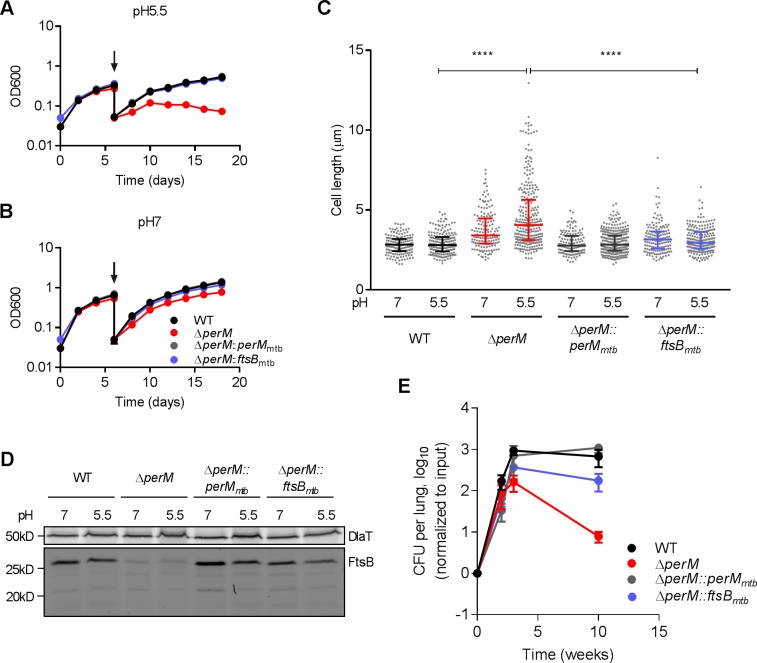
PerM is required for normal growth and cell division of Mtb in host-relevant stress conditions.(A,B) Growth curves of Mtb strains sequentially cultured in 7H9 medium adjusted to either pH 5.5 (A) or pH 7 (B). At day 6 (arrows), the cultures were diluted in the same medium and samples collected for length quantification. Data are means ± SD of three replicates. (C) Scatter plots of the cell length of Mtb 6 days post incubation at either pH 5.5 or pH 7. The middle lines represent the medians and the bottom and top lines represent the 25th and 75th percentiles. P-values were calculated using Kruskal-Wallis test and corrected for multiple comparisons. ****, adj-P <0.0001. (D) FtsB levels in whole-cell protein lysates assayed by western blotting with anti-FtsB antibody. Whole-cell protein lysates were collected from Mtb cultured in 7H9 medium adjusted to either pH 7 or pH 5.5 for 3 or 6 days. DlaT was used as loading control. (E) Bacterial titers in lungs of C57BL/6 mice infected with indicated Mtb strains. Data are means ± SD of four mice and normalized to input. Data in (A, B and D) are representative of two independent experiments, and data in (C and E) are from one experiment.
Figure 6—source data 1.Summary statistics of Figure 6C.